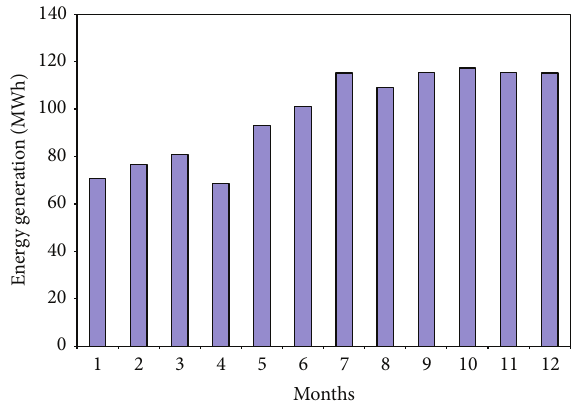
Figure 9: Annual energy generation from